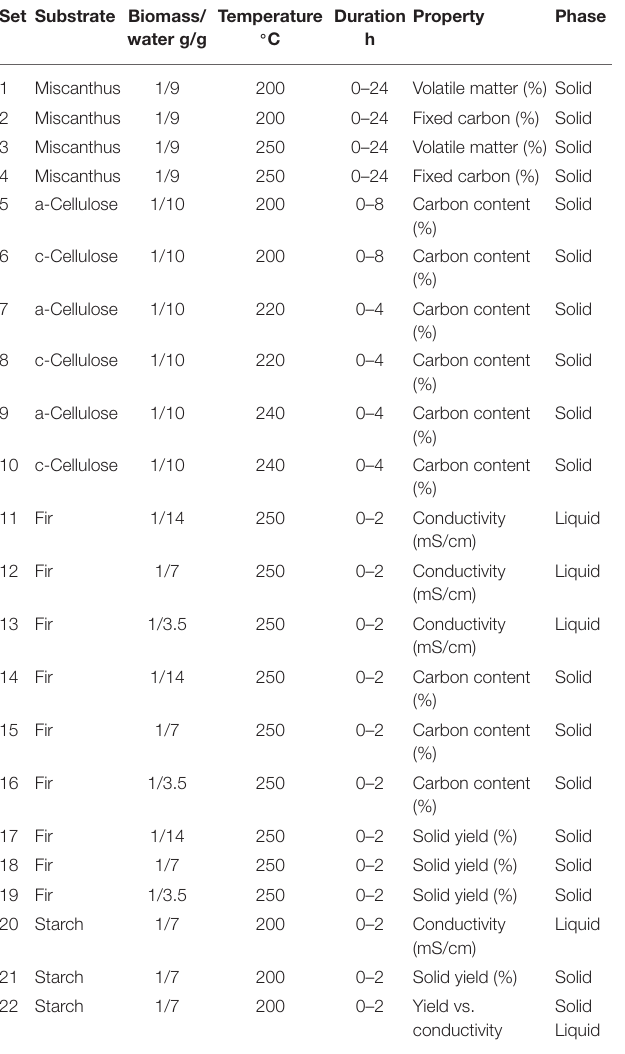
TABLE 1 | Synopsis of the data from literature and from this study. Set Substrate Biomass/ Temperature ◦ C water g/g